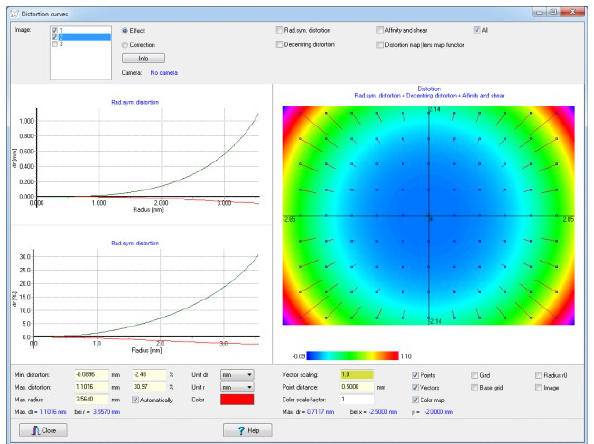
Figure 14: Distortion curves and pattern